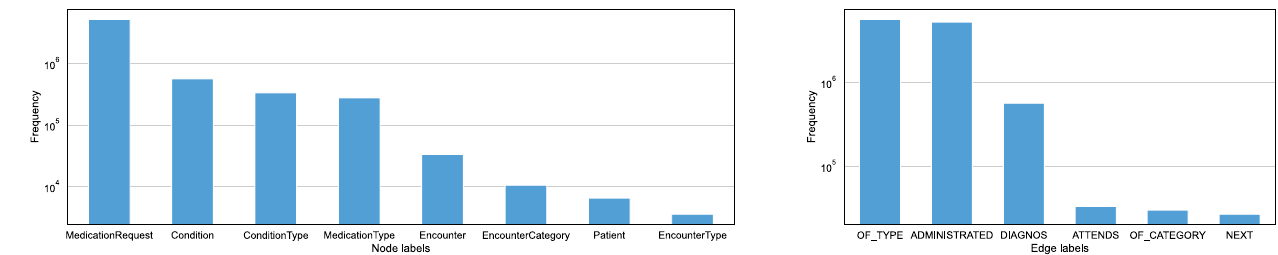
Fig. 2 Histogram of the number of (higher level) node labels and edge labels in the training data. There exist eight different (higher level) node labels and six different edge labels in total. Note that some higher-level node labels, such as MedicationType, and ConditionType, aggregate hundreds or even thousands of lower-level node